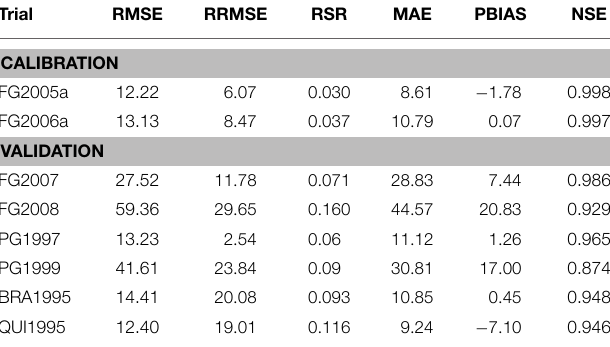
TABLE 4 | RMSE, Root mean square error; RRMSE, relative root mean square error; RSR, RMSE-observation standard deviation ratio; MAE, mean absolute error; PBIAS, percent bias; Nash-Sutcliffe efficiency (NSE) for the fittings performed on progression of N uptake in calibration and validation trials.